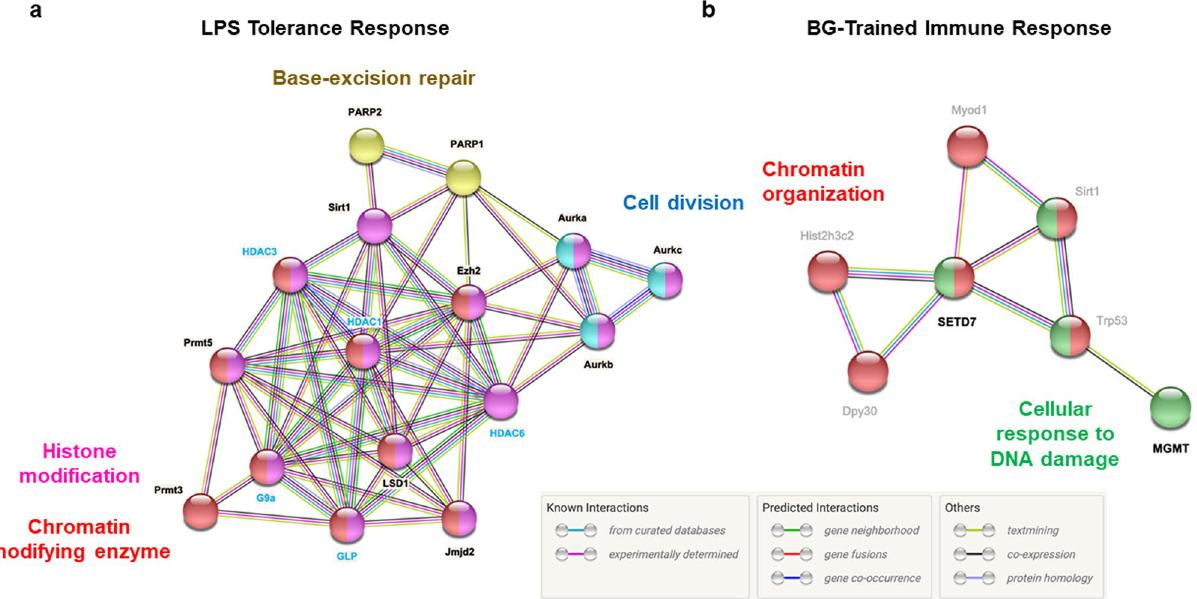
Figure 3. Possible interactions among the target proteins for the identified inhibitors. Potential interactions among target proteins of inhibitors identified in the screening for tolerance ( a ) and trained immunity ( b ) by STRING. The target proteins of inhibitors identified in this study are shown in black text while the potential functional partner proteins are shown in gray text. The interactions among proteins that are experimentally determined are linked with pink lines while the interactions predicted from curated database are shown in blue. Effective targets related to previous studies are represented in blue